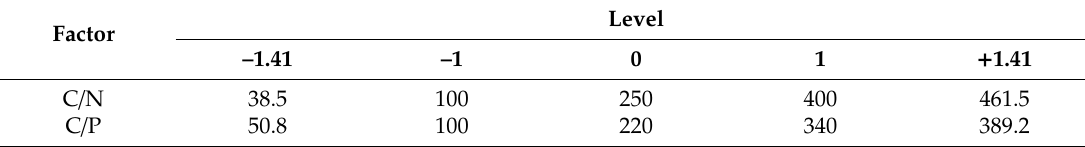
Table 4. Central composite design for cultivations with EHH at different C/N and C/P ratios. Factor